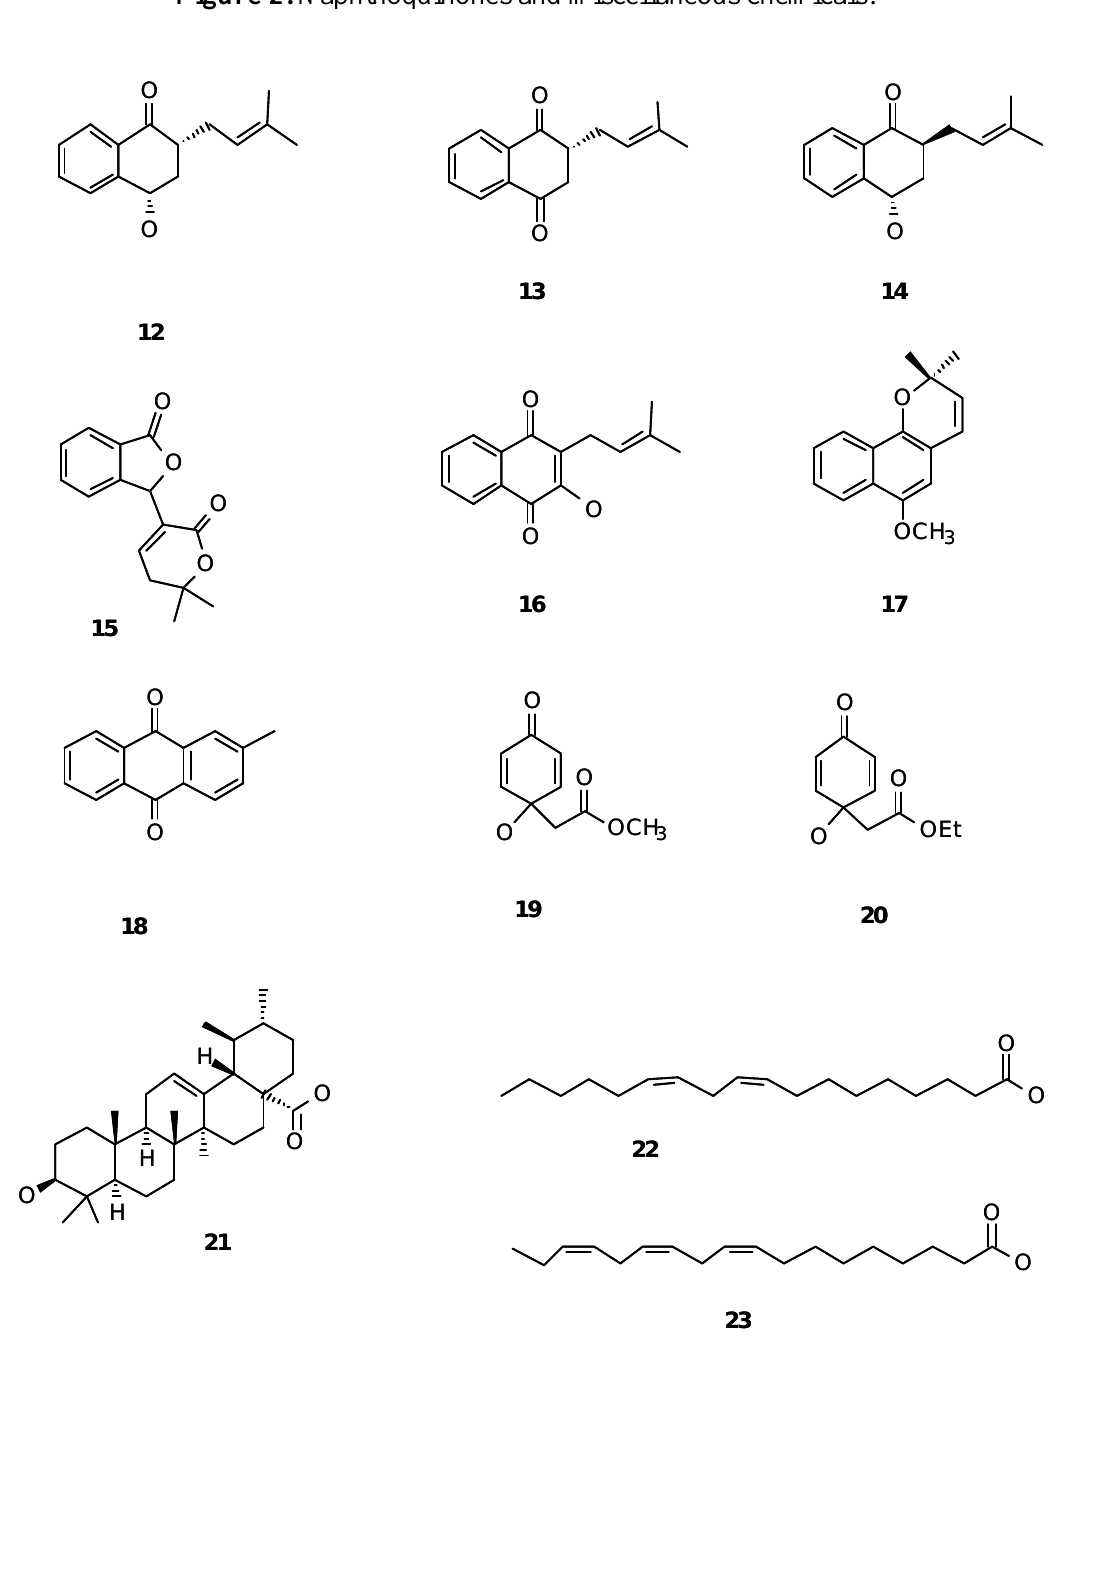
Figure 2. Naphthoquinones and miscellaneous